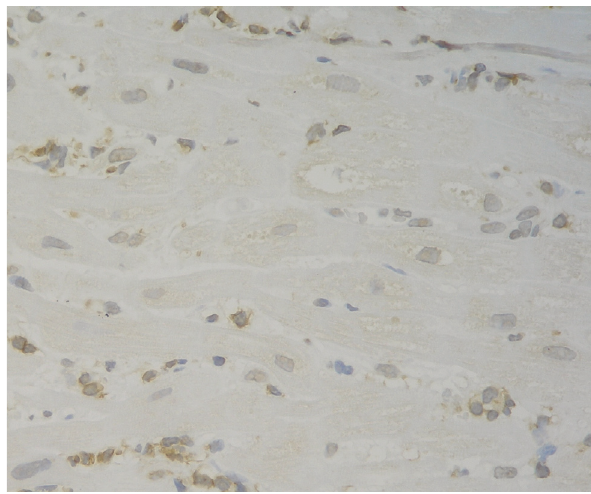
Fig. 1. Myocardial tissue sample depicting presence of CD3 positive T-lymhocytes (CD3 positive cells are stained brown; magnification